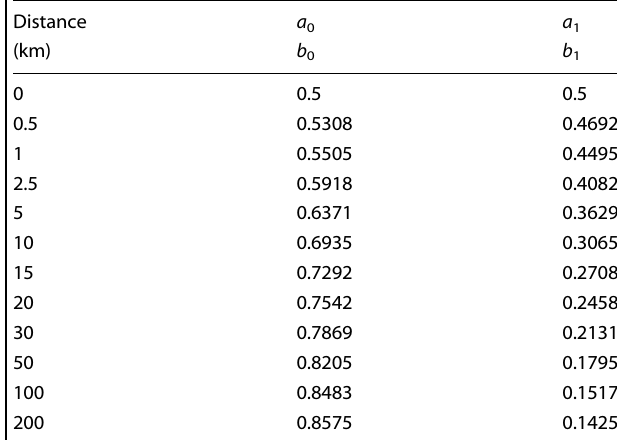
Table 3. The coef fi cients of the optimised states with n max ¼ 1 photon.